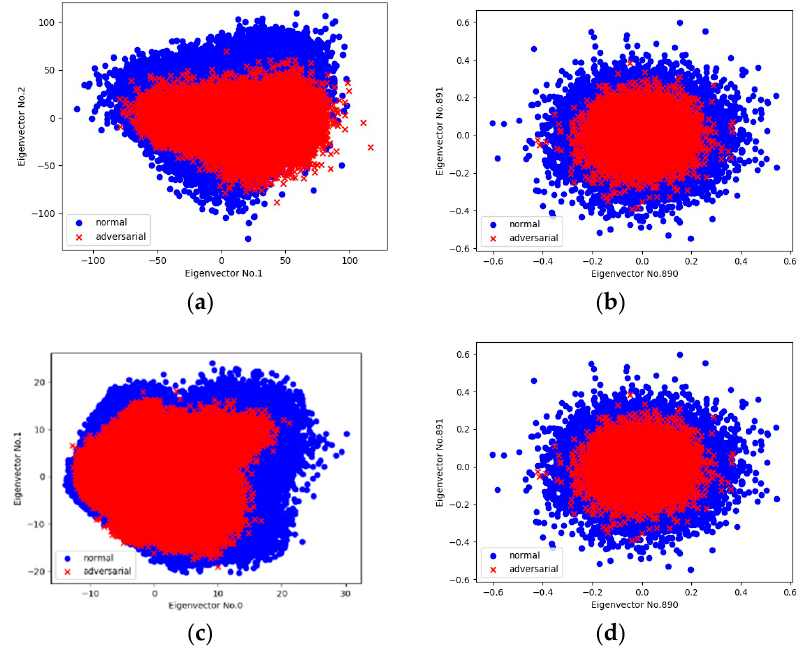
Figure 3. Scatter plots of principal component analysis (PCA) projection of activations at the first fully connected layer onto specific eigenvectors in the target classifier. Blue area indicates normal examples and red area indicates adversarial ones. Illustrated by the case of the ImageNet validation set: ( a ) projection onto the 1st and 2nd eigenvectors; ( b ) projection onto the 890th and 891st eigenvectors. Illustrated by the case of the MNIST testing set: ( c , d ) are projections onto the same eigenvectors as ( a , b ), respectively.